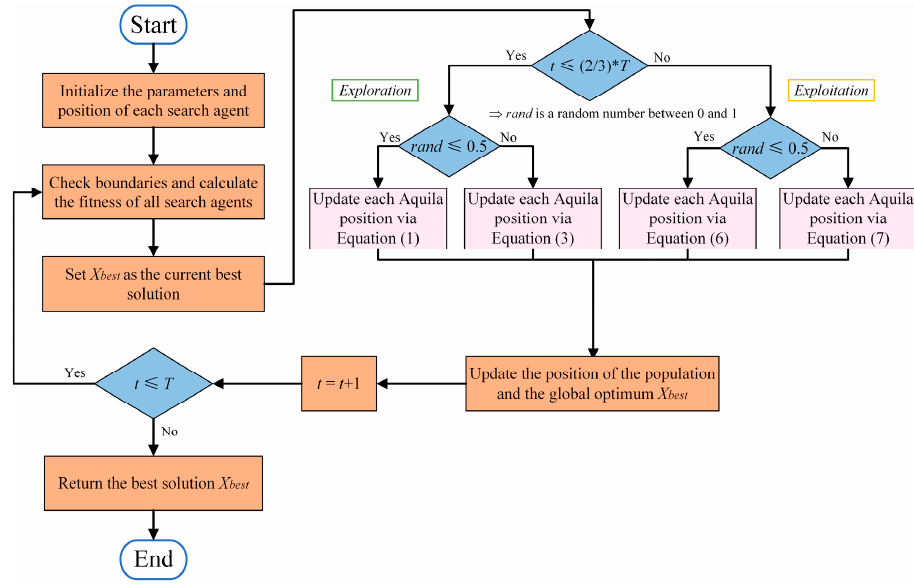
Figure 1. Flow chart of AO.